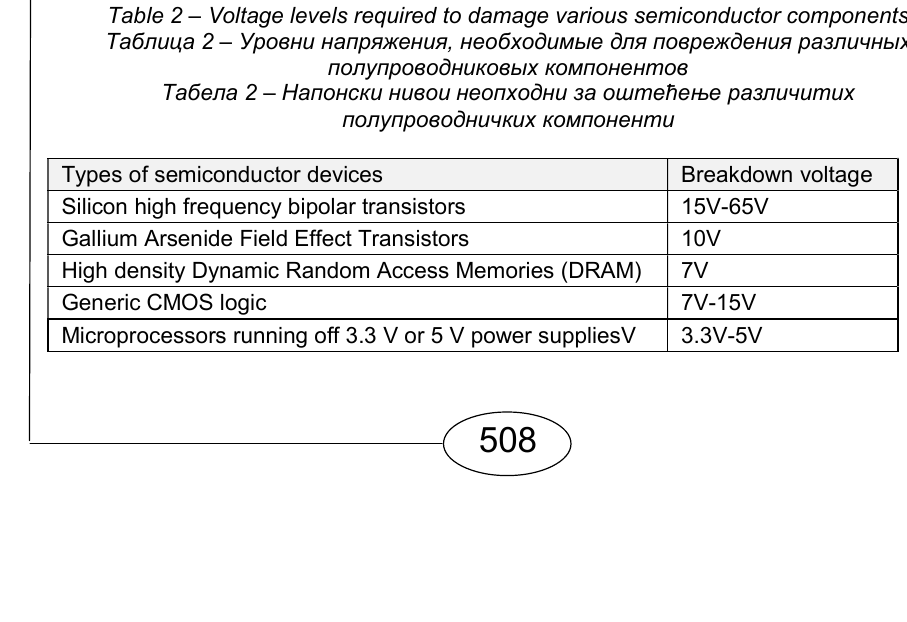
Table 2 – Voltage levels required to damage various semiconductor components Таблица 2 – Уровни напряжения, необходимые для повреждения